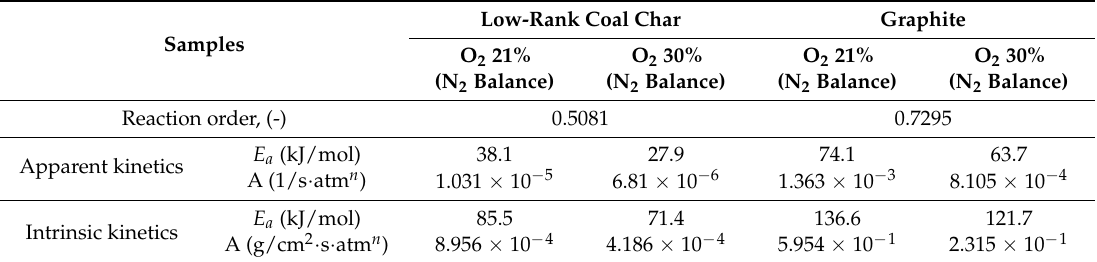
Figure 9. Effectiveness factors as a function of particle temperature at an ambient oxygen concentration of 30%. Table 4. Linear regression results for the intrinsic reaction rates expressed as n th-order Arrhenius equations.